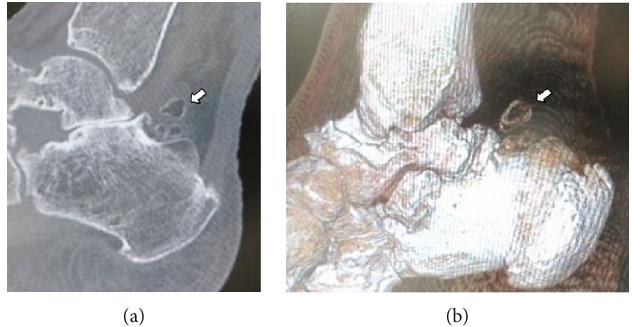
Figure 3: Computed tomography scans showing homogeneous calci fi cations with typical ring-and-arc chondroid mineralization in the posterior ankle (a) on a plain sagittal view (arrow) and (b) on a three-dimensional image view (arrow).